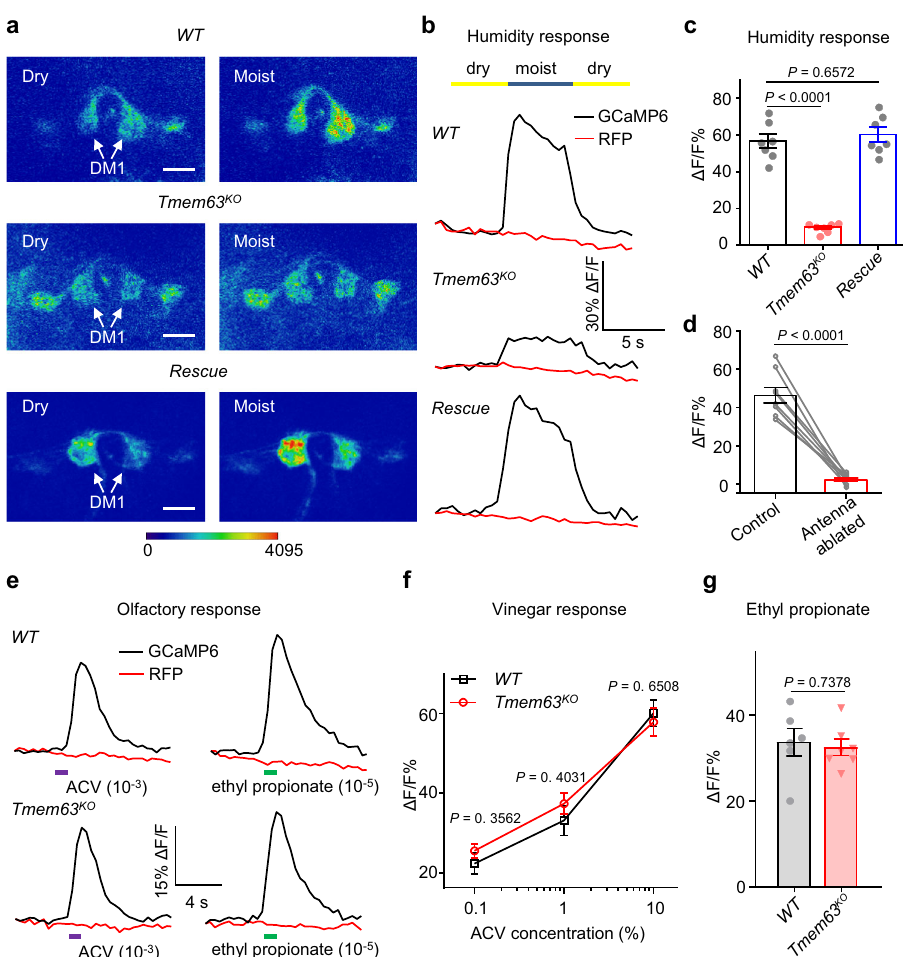
Fig. 5 Tmem63 -dependent calcium response to humidity changes in Or42b neurons. a Pseudocolored images of Ca 2 + dynamics in response to humidity changes for the wild type ( Nan-Gal4 / + ; UAS-GCaMP6m,UAS-tdTomato / + ), Tmem63 KO ( Nan-Gal4,Tmem63 KO / Tmem63 KO ; UAS-GCaMP6m,UAS-tdTomato / + ) and Rescue ( Nan-Gal4,Tmem63 KO ; UAS-GCaMP6m,UAS-tdTomato / UAS-DmTMEM63 ) animals. White arrows denote the DM1 glomerulus. Scale bar, 20 μ m. Each result was repeated over three times. b Representative traces of the Ca 2 + response of the DM1 glomerulus to humidity changes in wild type , Tmem63 KO mutant and Rescue fl ies. c Statistical analysis of the Ca 2 + response in the Or42b neurons of wild type , Tmem63 KO and Rescue fl ies to a switch from dry air to moist air. n = 7 fl ies for each group. One-way ANOVA followed by Dunnett ’ s test. d Humidity responses in the DM1 glomerulus prior to and after surgical resection of the bilateral antennal nerve. n = 8 fl ies. Two-tailed paired t test. e Representative traces of the Ca 2 + response of the Or42b neurons in wild type (upper panel) and Tmem63 KO (lower panel) fl ies to 10 -3 dilution of vinegar (magenta bar) and 10 − 5 dilution of ethyl propionate (green bar). f Statistical analysis of the Ca 2 + response in the Or42b neurons from wild type and Tmem63 KO fl ies to apple cider vinegar in different concentrations. n = 7, 6 fl ies. g Quanti fi cation of peak Δ F/F 0 response to ethyl propionate. n = 6, 7 fl ies. f , g Two-tailed unpaired t test. Data are mean±SEM. Source data are provided as a Source Data fi